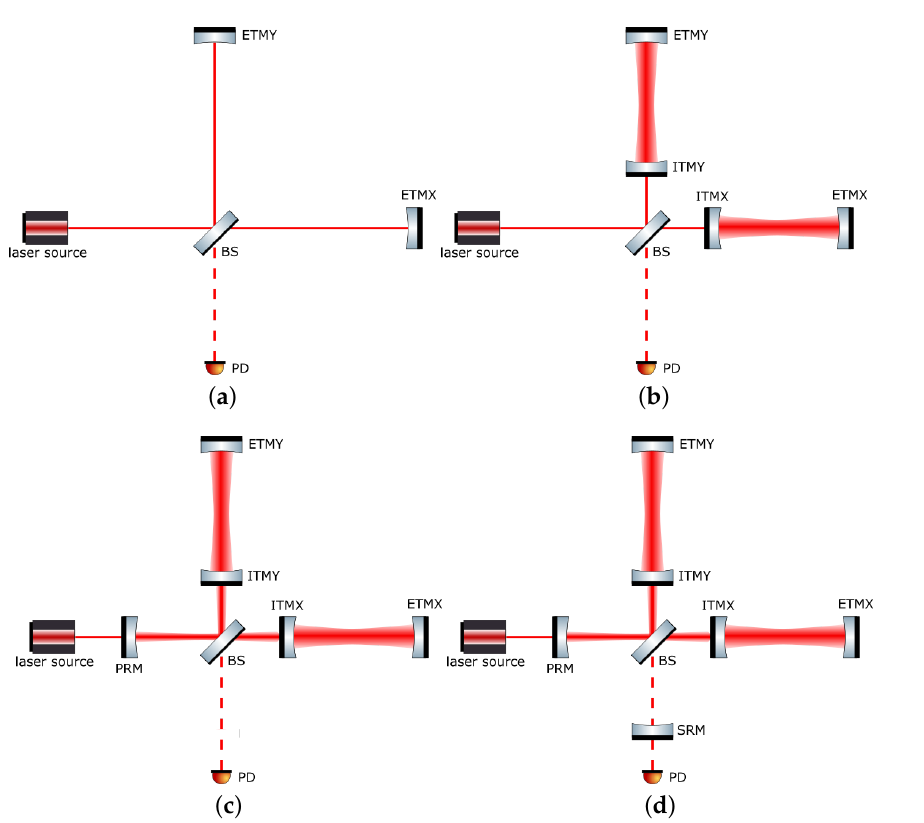
Figure 2. Schematic image of the interferometer configuration. A basic Michelson interferometer ( a ) consists of a laser source, beam splitter (BS), end test masses (ETMX and ETMY), and photode- tector (PD). The Fabry–Pérot arm cavities, which are composed of ETMs and input test masses (ITMX and ITMY), extend the effective arm length ( b ). The power-recycling mirror (PRM) and signal-recycling mirror (SRM) improve the sensitivity using the power-recycling technique and resonant sideband extraction technique, respectively ( c , d ). ( a ) Michelson interferometer (MICH). ( b ) Fabry–Pérot Michelson interferometer (FPMI). ( c ) Power-recycling FPMI (PRFPMI). ( d ) Resonant sideband extraction (RSE)